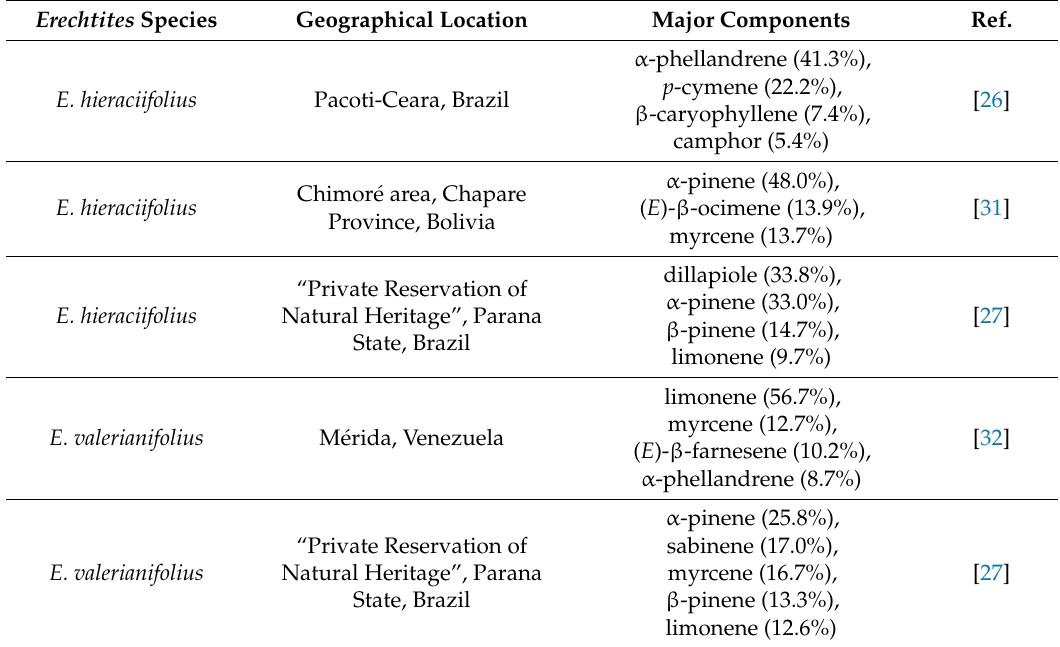
Table 3. Major chemical components (>5%) of Erechtites essential